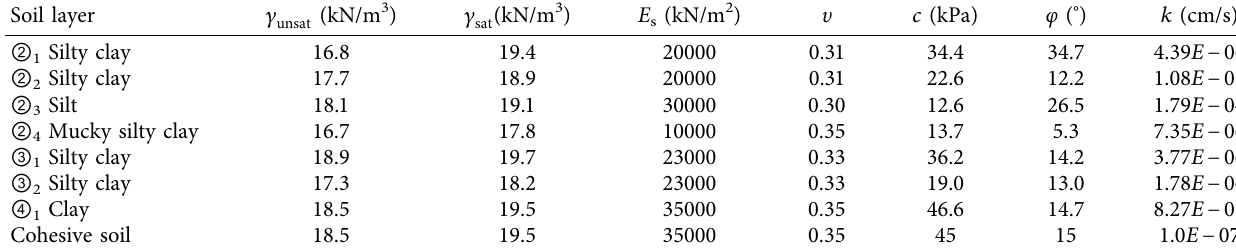
Table 2: Summary of main geotechnical properties of soil layers.